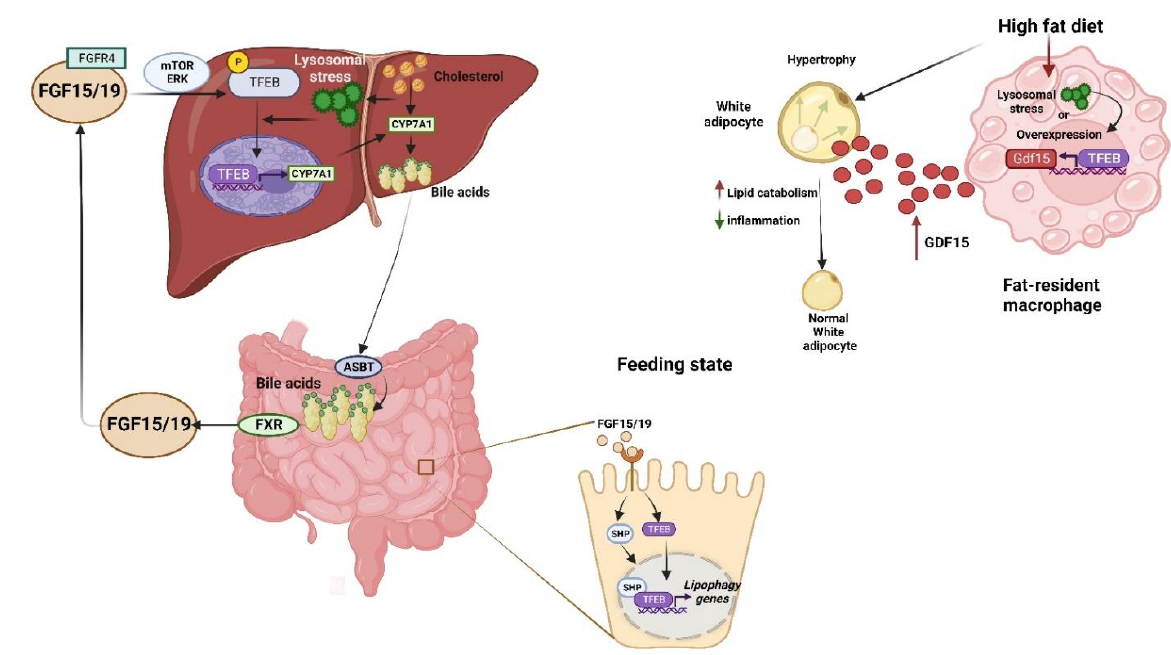
Figure 5. The TFEB is expressed in several tissues, including the liver, intestine, and white adipose tissue. In these cell types, in response to several stimuli, TFEB is activated and induces the expression of several genes, as indicated in the figure. In the liver, cholesterol accumulation causes lysosomal stress, which consequently induces TFEB nuclear translocation, activating the expression of cholesterol 7α -hydroxylase (CYP7A1) to produce hepatic bile acid synthesis that, in the intestine cells, promotes the production of the hormone fibroblast growth factor-15/19 (FGF15/19), and this consequently activates both the activate orphan nuclear receptor, the small heterodimer partner (SHP/NR0B2) and TFEB, to activates genes (Ulk1 and Atgl) essential for lipophagy. TFEB activation by overexpression or the occurrence of lysosomal stress in fat-resident macrophages protects against diet-induced weight gain and adiposity through the induction of growth differentiation factor 15 (GDF15)-enhanced adipose lipid catabolism, and it reduces